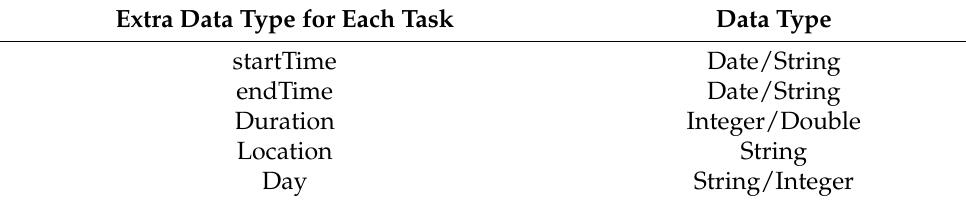
Table 8. Additional data for recognition of